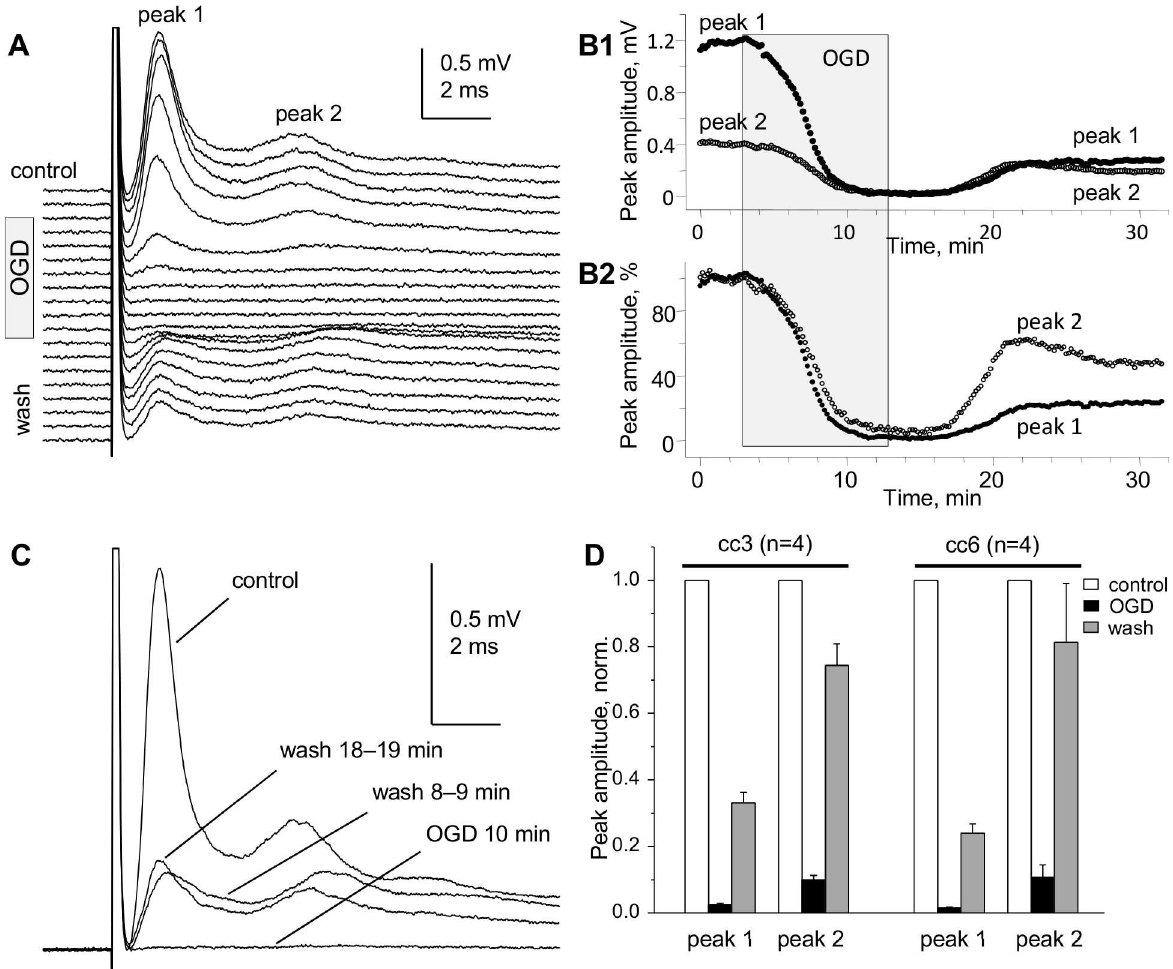
Fig 7. Pronounced effects of oxygen glucose deprivation (OGD) on “whole” CC CAPs. (A) Superimposed CC CAPs recorded before (control), duringOGD and duringwashout. (B1, B2) Time course of changesof absolute (B1) and normalized (B2) amplitudes of peaks 1 and 2 during 10-minute OGD and 20-minute washout. (C) Superimposed CAPs before, duringand after OGD. (A-C) Representative data from a single experiment on CC6. The CAPs were recordedwithout averaging to reflect the fast changesduringthe test. (D) Summary of OGD–induced changesof CAP peaks after 10 min OGD and 20 min washout in CC3 and CC6. Temperature